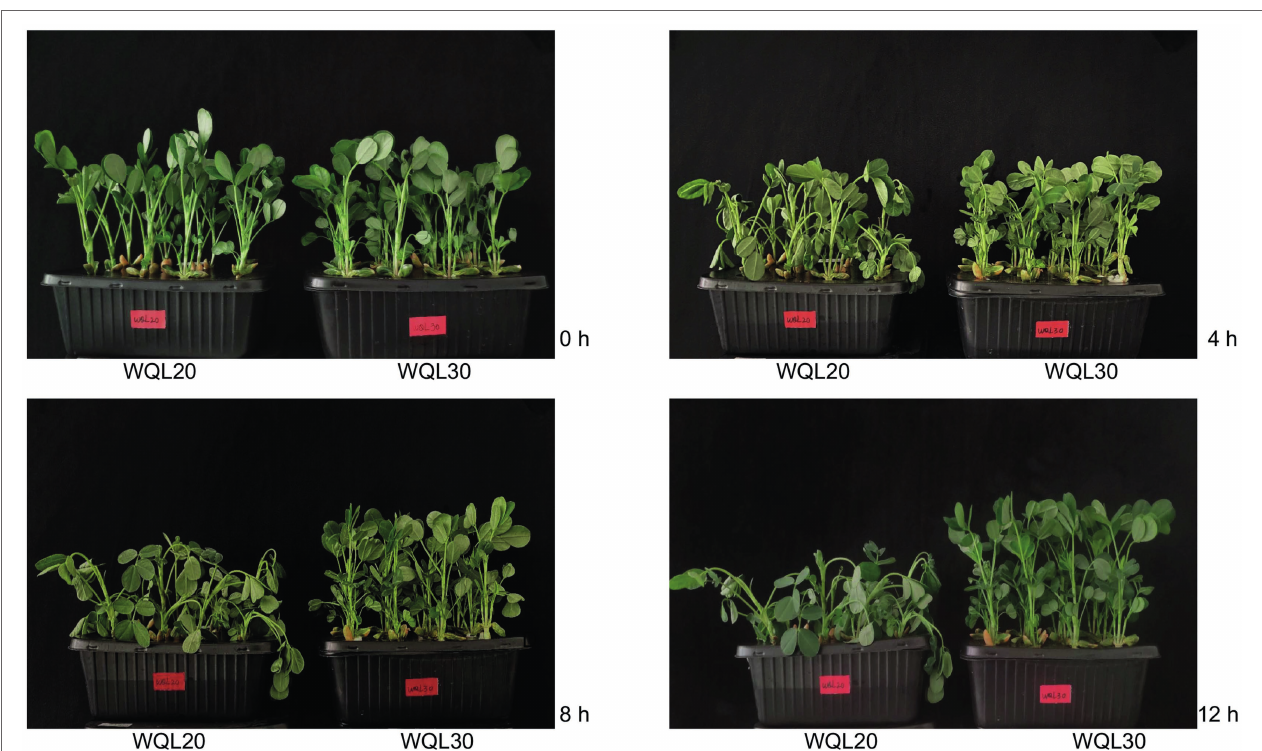
FIGURE 1 | The phenotype of peanut exposed to low temperature. For low-temperature treatment, four-leaf stage seedlings of WQL30 and WQL20 were kept in a growth chamber at 6 ° C, 70% RH, and a 14-h/10-h light/dark photoperiod. With the increase of treatment time, WQL20 began to wilt, while WQL30 did not change significantly after 4 h of cold treatment. After 8 h of cold treatment, WQL20 wilted significantly, but WQL30 still had no noticeable change. After 12 h of cold treatment, WQL20 wilted and fell, while WQL30 showed slight wilting symptoms as shown in this figure. The pictures were taken at 0 HCT, 4 HCT, 8 HCT, and 12 HCT and assembled in Adobe Photoshop